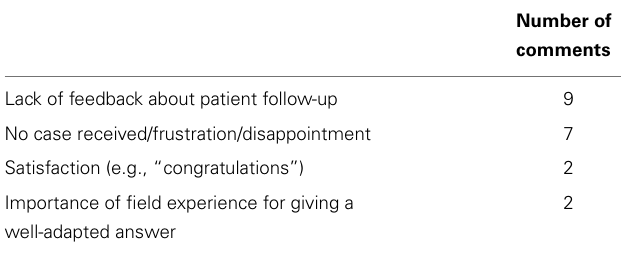
Table 6 | Summary of specialist comments (open-ended questions)